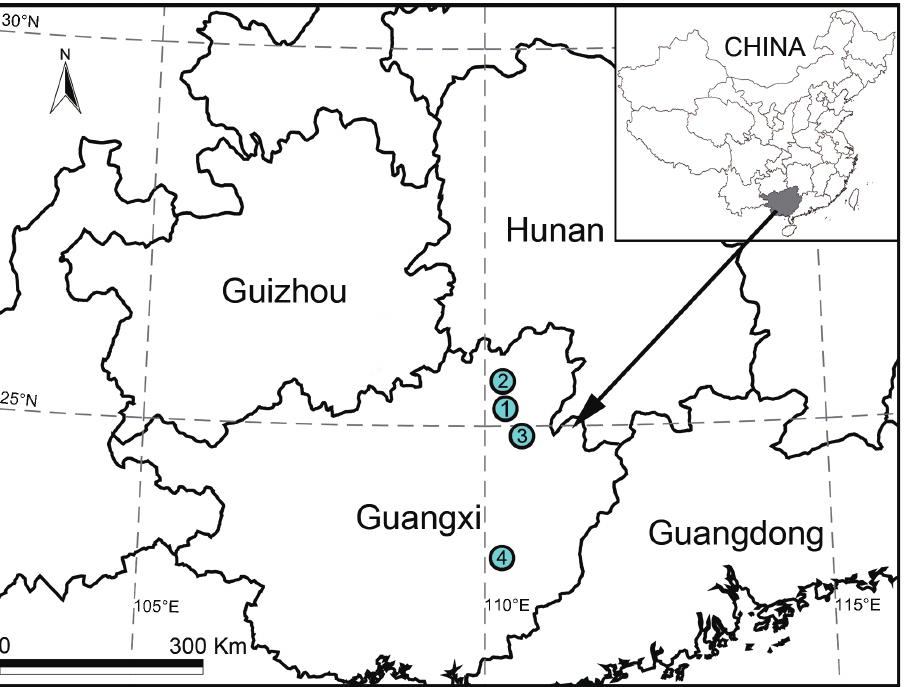
Figure 8. Localities of Guilotes species in China. 1 G. ludiensis sp. n. 2 G. qingshitanensis sp. n. 3 G. xing- pingensis sp. n. 4 G. yandongensis sp.